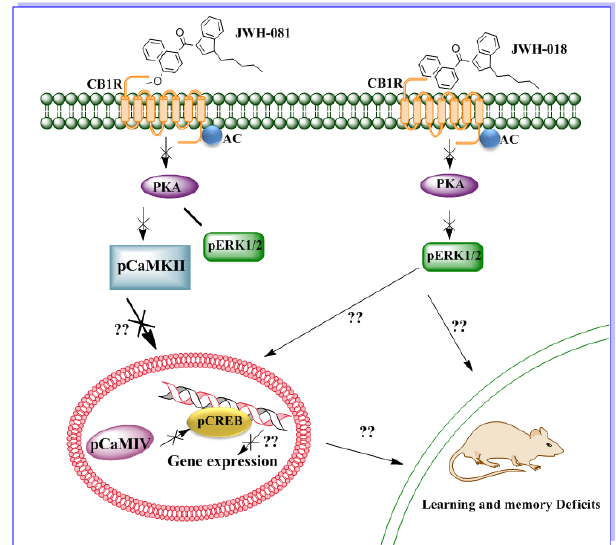
Figure 6. Schematic diagram showing the CB1R signaling mechanism of the SCBs found in Spice products. JWH-081 and JWH-018 both act on CB1R but activate distinct CB1R signaling events. JWH-018, which has a higher a ffi nity for CB2R than for CB1R, reduces pERK1 / 2. JWH-081, which has a stronger a ffi nity for CB1R than for CB2R, does not a ff ect pERK1 / 2 but does impair pCaMKIV and pCREB levels, which are linked with Arc gene